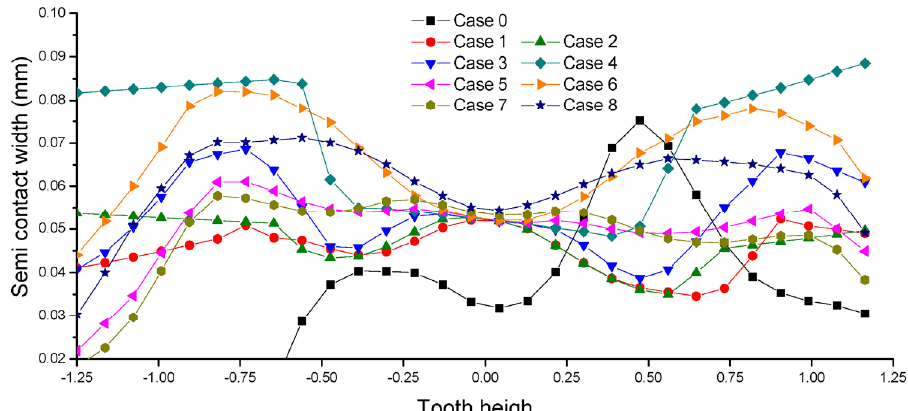
Fig. 8 Semi contact width at different points in the